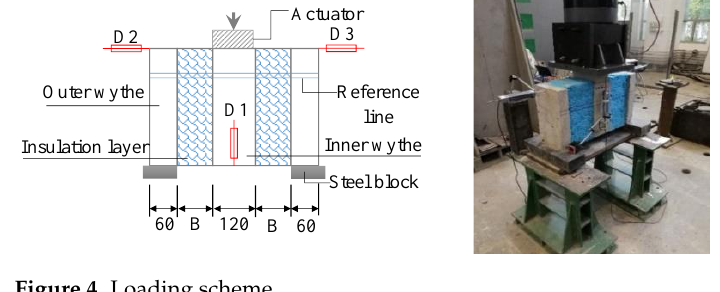
Figure 4. Loading scheme.